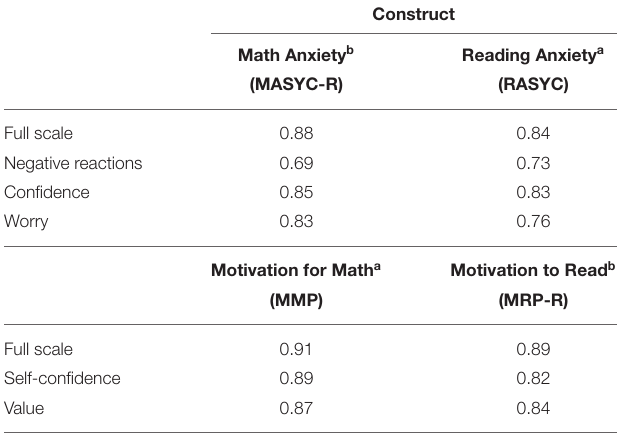
TABLE 2 | Cronbach’s alpha for each full scale and subscale ( n =